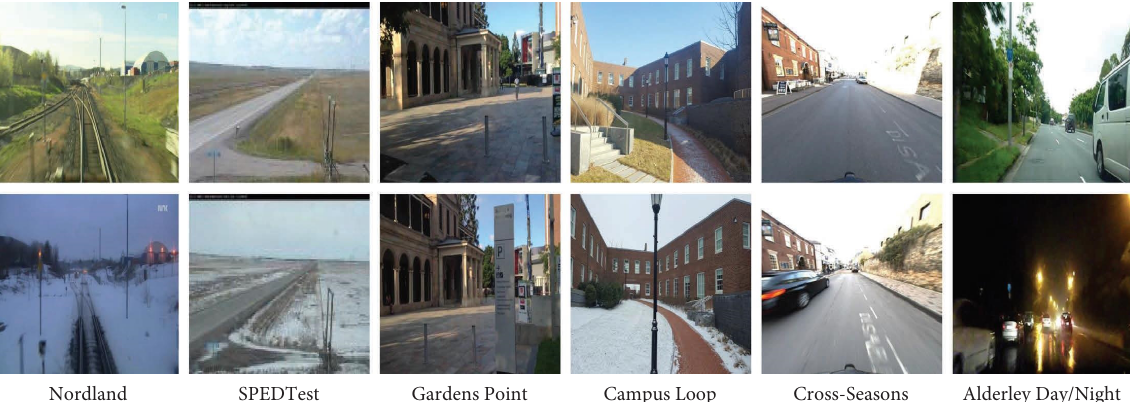
Figure 2: Sample images from 6 benchmark